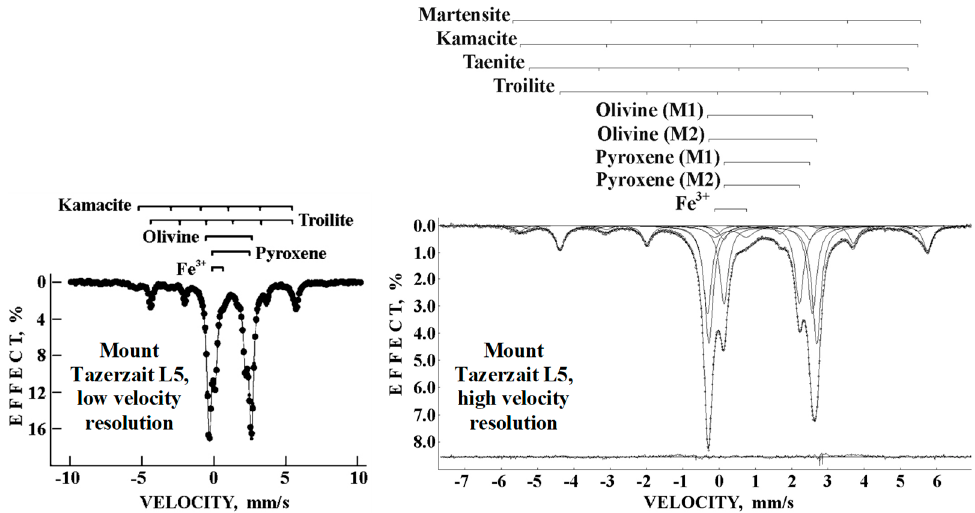
Figure 1. Mössbauer spectra of Mount Tazerzait L5 samples measured: ( left ) using conventional Mössbauer spectrometer with a low velocity resolution and folding (in 256 channels) from Ref. [8] cited in [17]; and ( right ) using Mössbauer spectrometer SM-2201 with a high velocity resolution (4096 channels) without folding (this spectrum was further converted into 1024-channel spectrum to increase signal-to-noise ratio for the minor spectral components); the differential spectrum is shown below. T = 295 K. Adopted from [17].